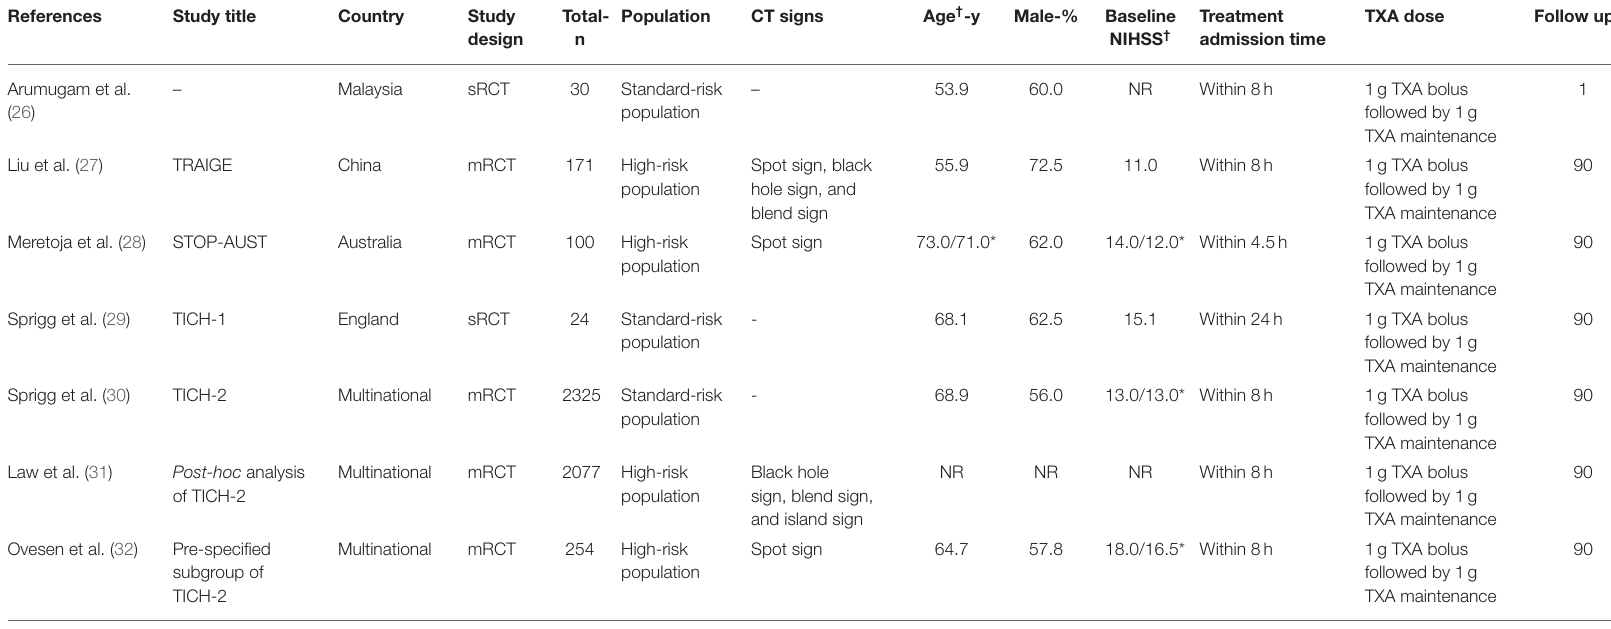
TABLE 1 | Baseline characteristics of included